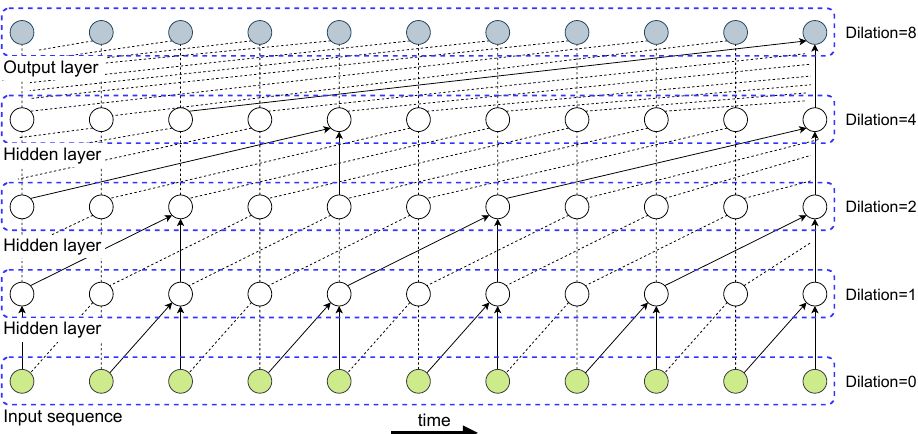
Figure 3. Representation of a stack of causal convolutional layers with different dilation